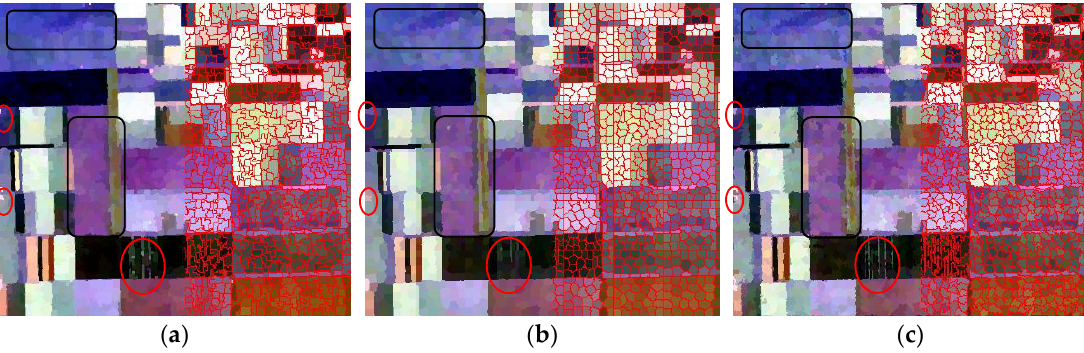
Figure 6. The superpixel segmentation results obtained with the AirSAR PolSAR image: ( a ) GMS segmentation, with N r = 2021; ( b ) Ncut segmentation, with N r = 2016; and, ( c ) Simple Linear Iterative Clustering algorithm for PolSAR image with the grid-centered initialization strategy (SLIC-GC) segmentation, with N r = 2081.